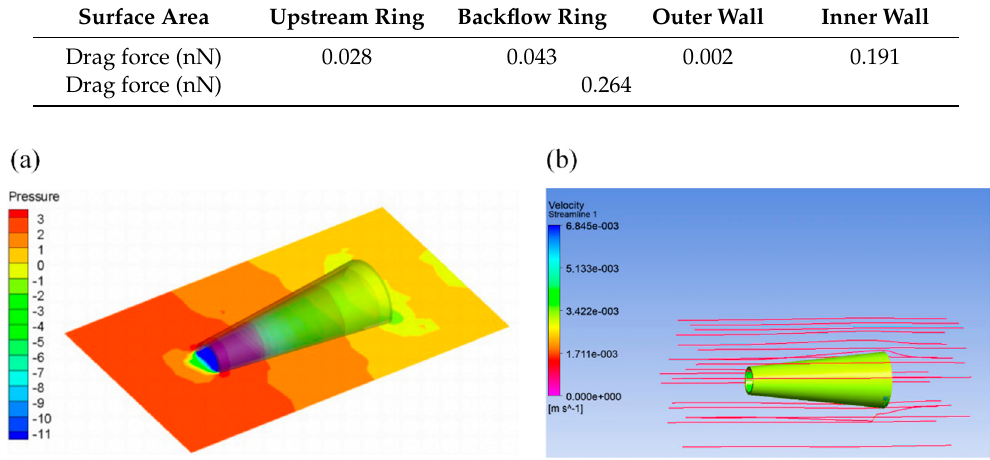
Figure 12. Tubular micromotor ( a ) pressure distribution and ( b ) streamline.